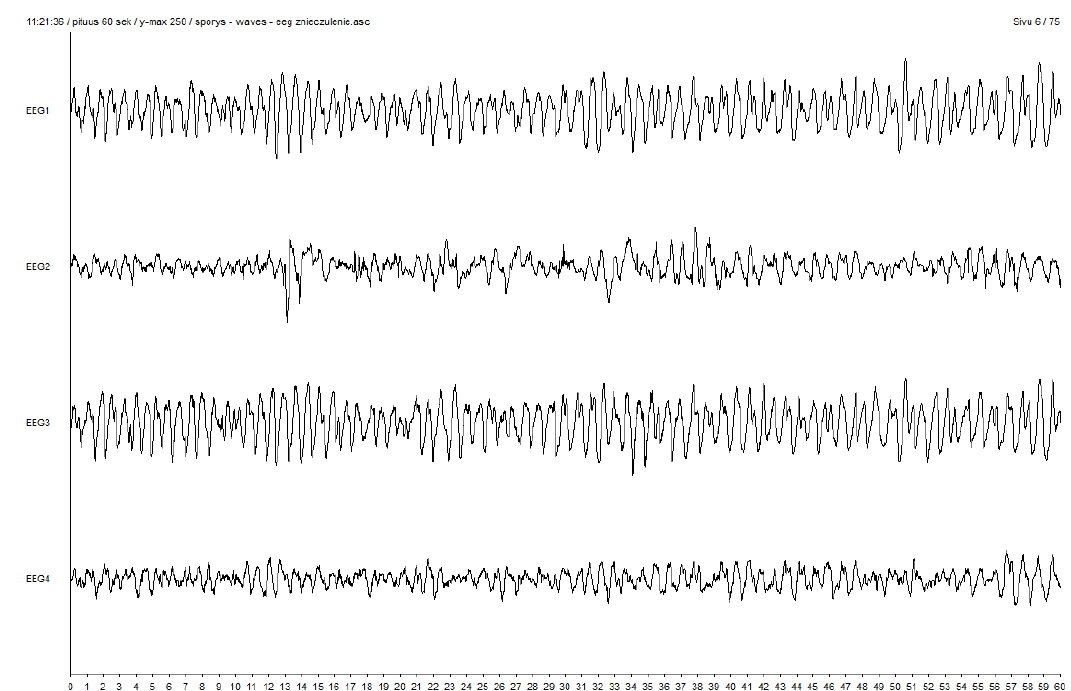
Figure 5. Epileptiform activity during the lowest values of RE and SE at fifth stage of VIGA with sevoflurane using VIMA technique.